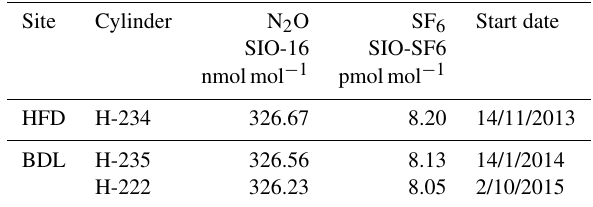
Table 4. GC–ECD standard cylinder mole fractions and usage start